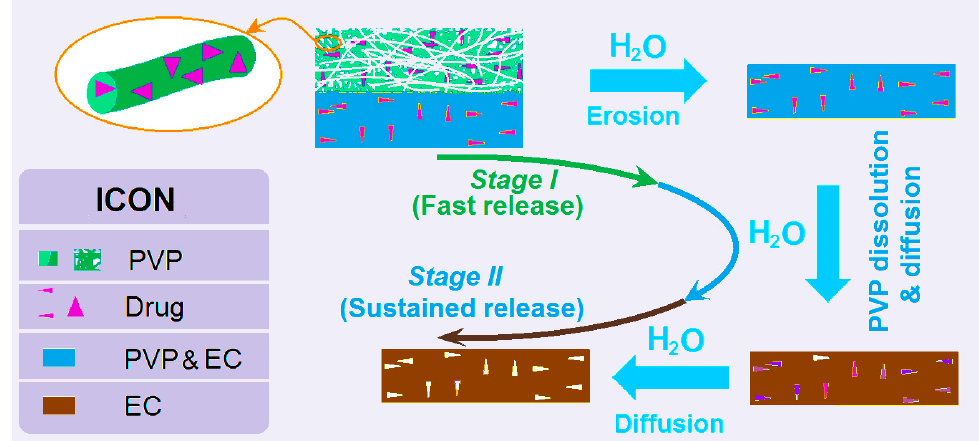
Figure 10. Mechanism diagram of dual-phase release from the DHFs F9.